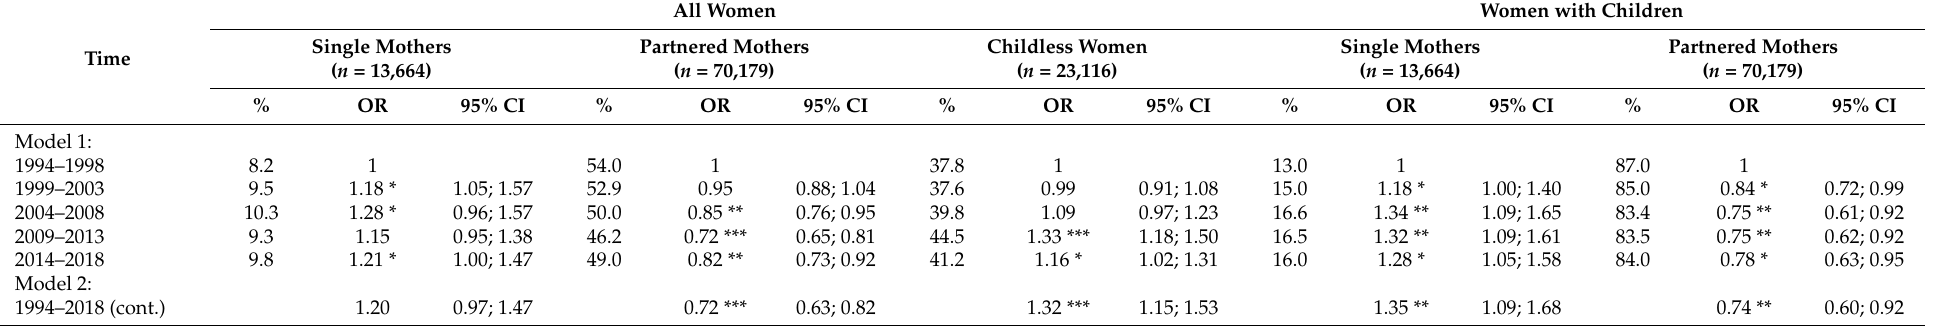
Table 3. Development of family status in women aged 30–49 years, Germany,